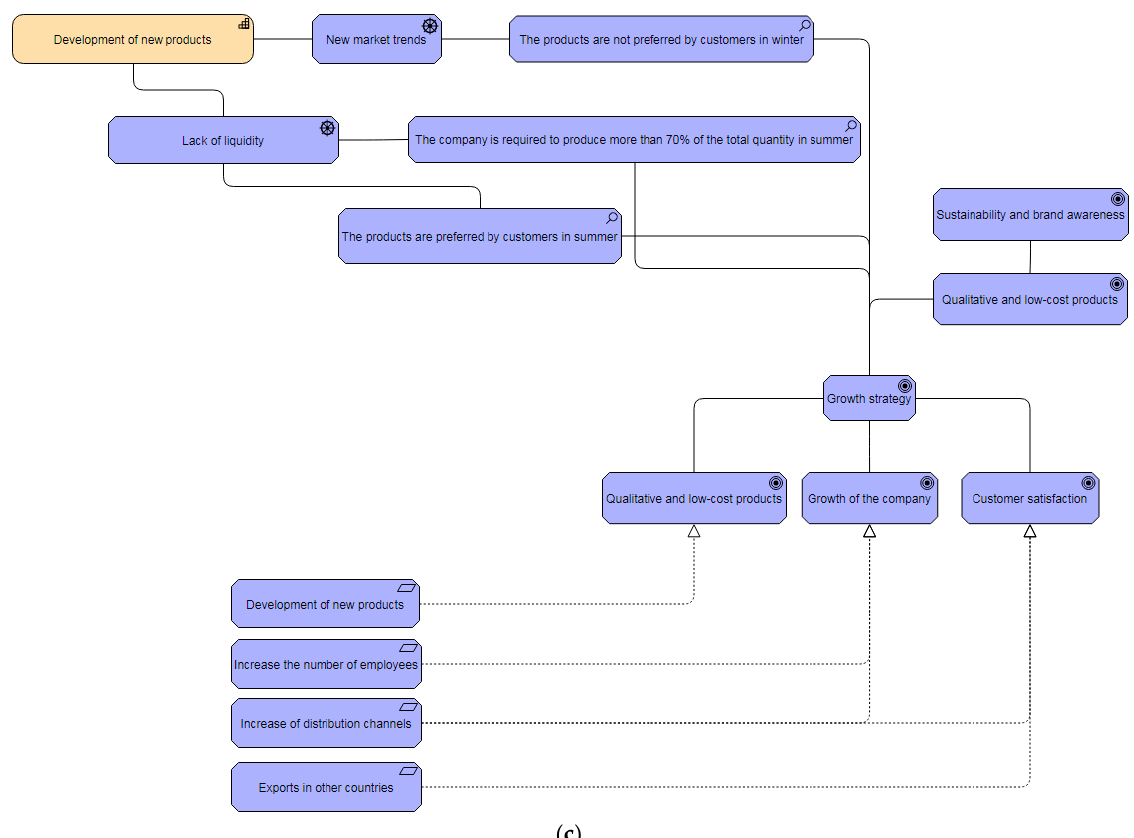
Figure 13. Modelling the company’s holistic strategic planning process ( a ). Modelling the company’s holistic strategic planning process ( b ). Modelling the company’s holistic strategic planning process ( c ).